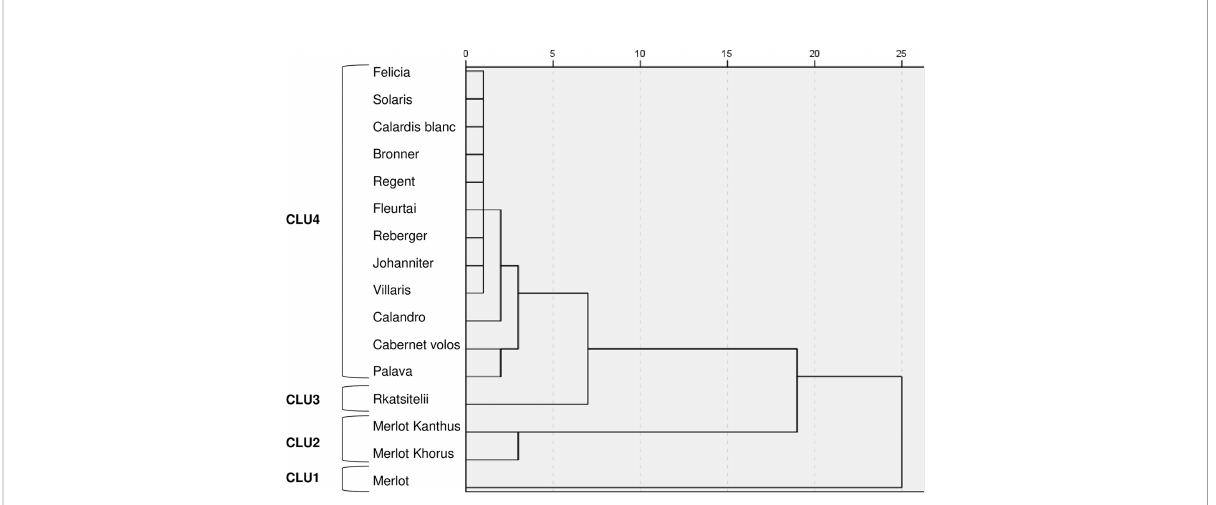
FIGURE 5 Dendrogram resulting from a hierarchical cluster analysis of the AUDPC values on leaves and bunches for downy mildew, powdery mildew, and black-rot in the 4-year period. CLU1 to CLU4 represent the four clusters at 5-unit dissimilarity cut-off